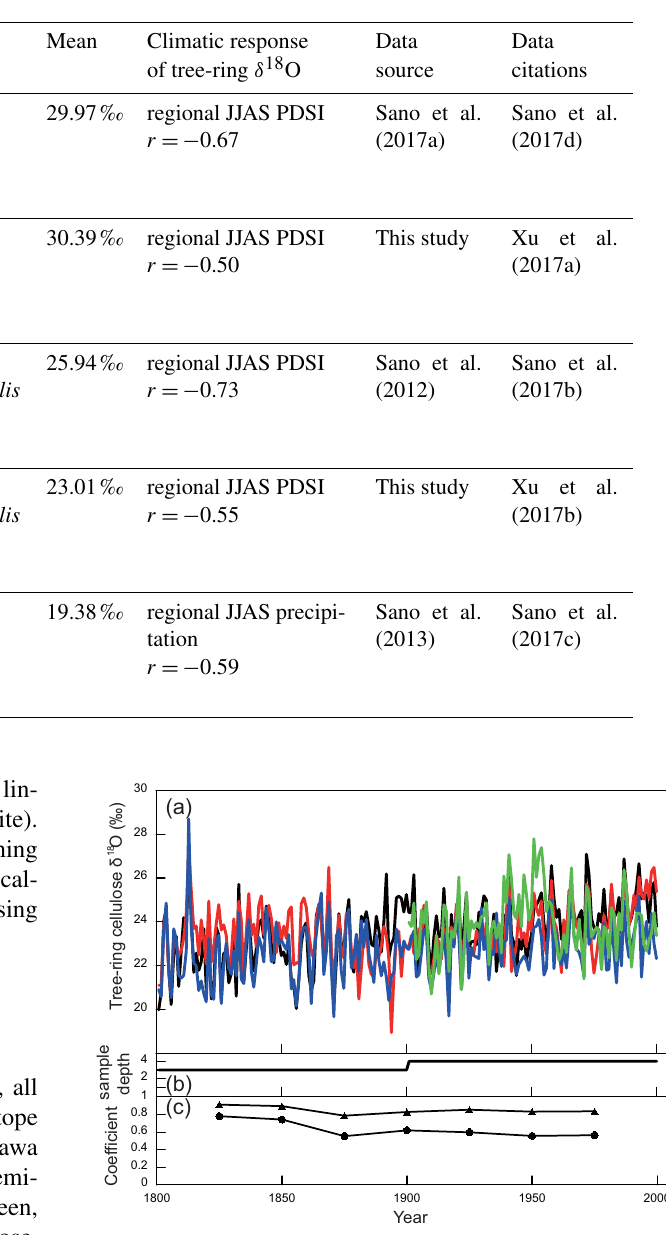
Figure 2. (a) Tree-ring δ 18 O series of four individual trees: (b) sample size and (c) running EPS and Rbar statistics used 50- year windows and a 25-year lag for samples near Ganesh, Nepal.